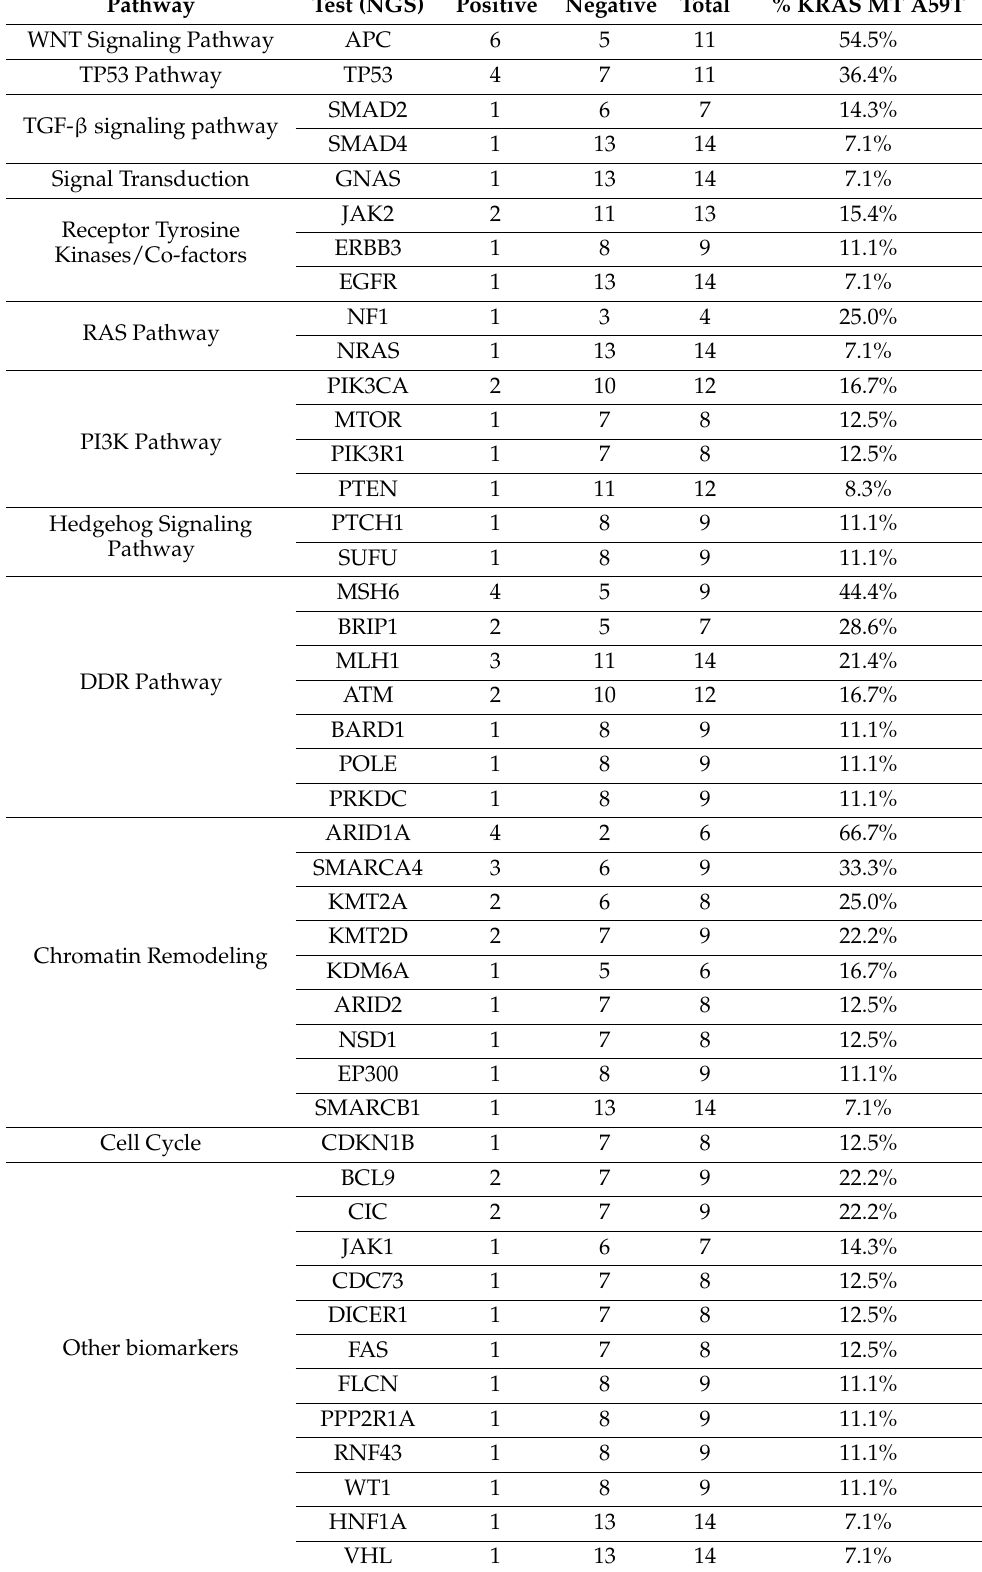
Table 3. List of identified prevalent mutations co-occurring with KRAS A59T mutations in CRC, sorted in the context of molecular